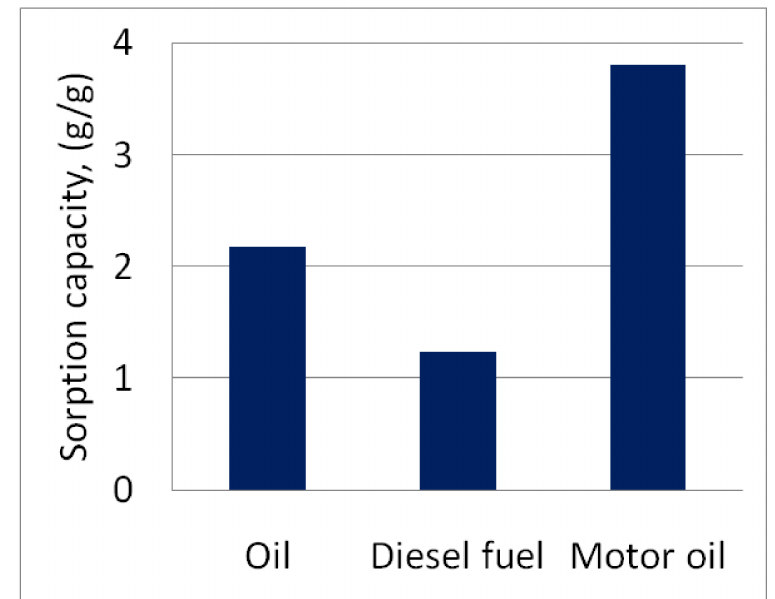
Figure 8. Sorption capacity of ChZn sample relative to oil and its